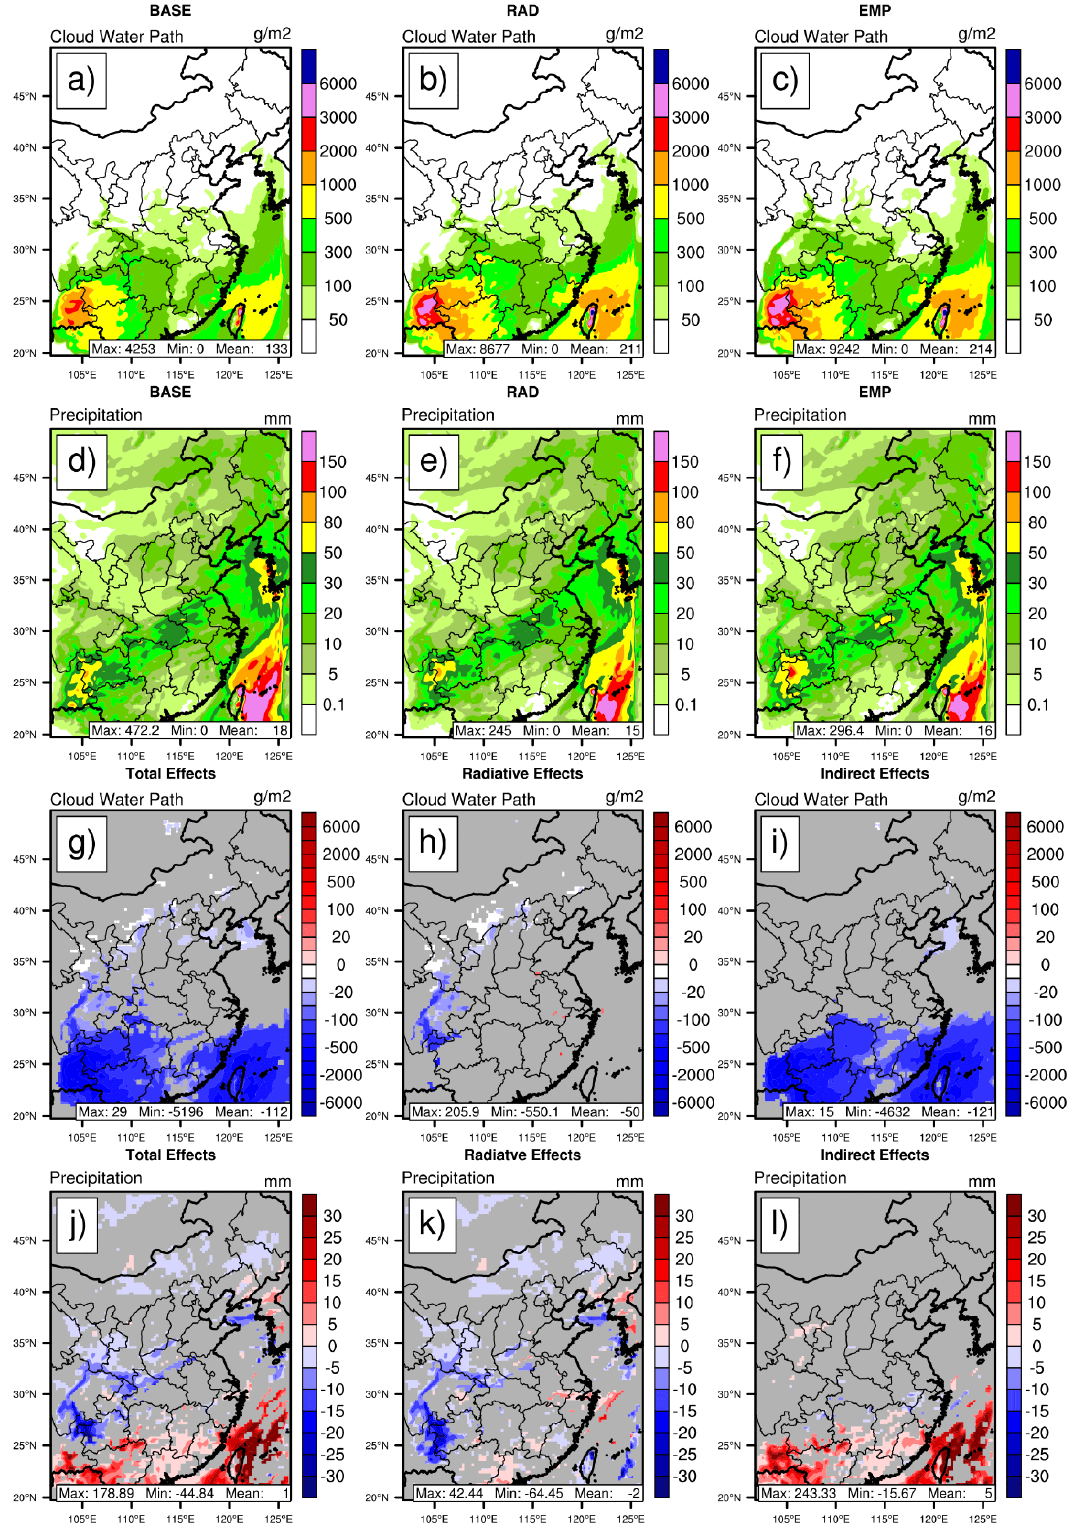
Figure 8. Simulated cloud water path (a–c) and precipitation (d–f) for the three scenarios and aerosol total effects (BASE − EMP) ( g , j ), radiative effects (RAD − EMP) ( h , k ), and indirect effects (BASE − RAD) ( i , l ) over eastern China in January 2013. Grey shaded areas indicate regions with less than 95%